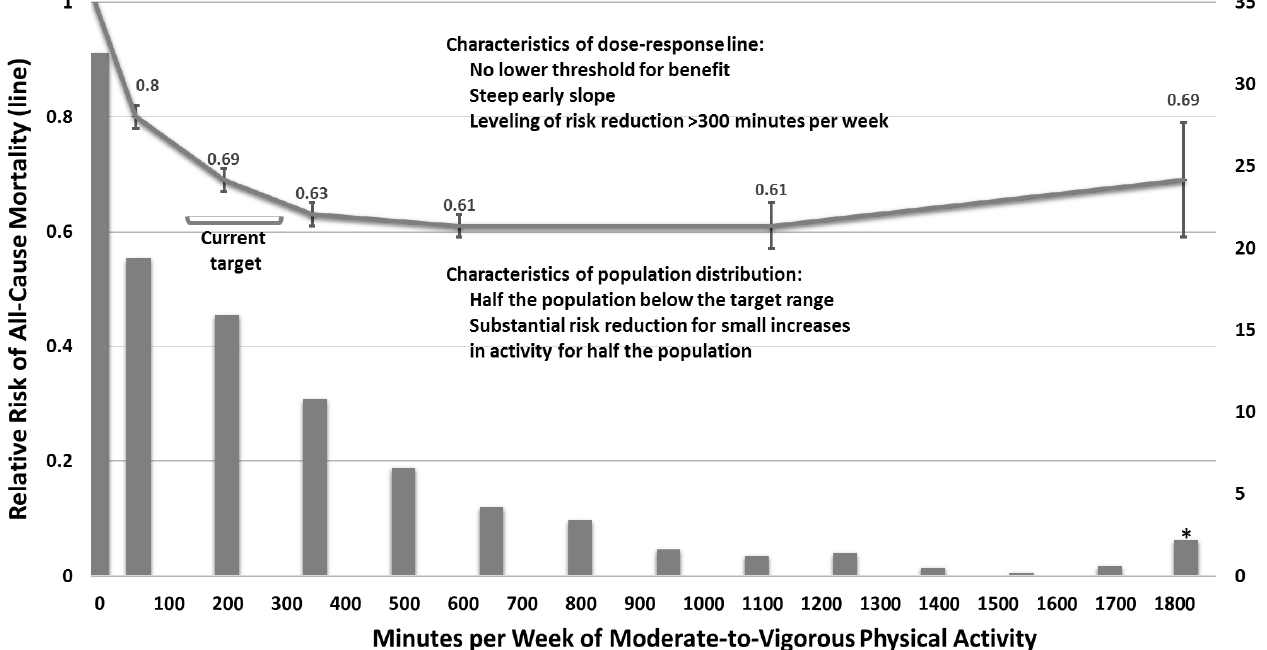
Figure D-1. Risk of All-Cause Mortality and Self-Reported Physical Activity, by Minutes of Moderate- to-Vigorous Physical Activity per